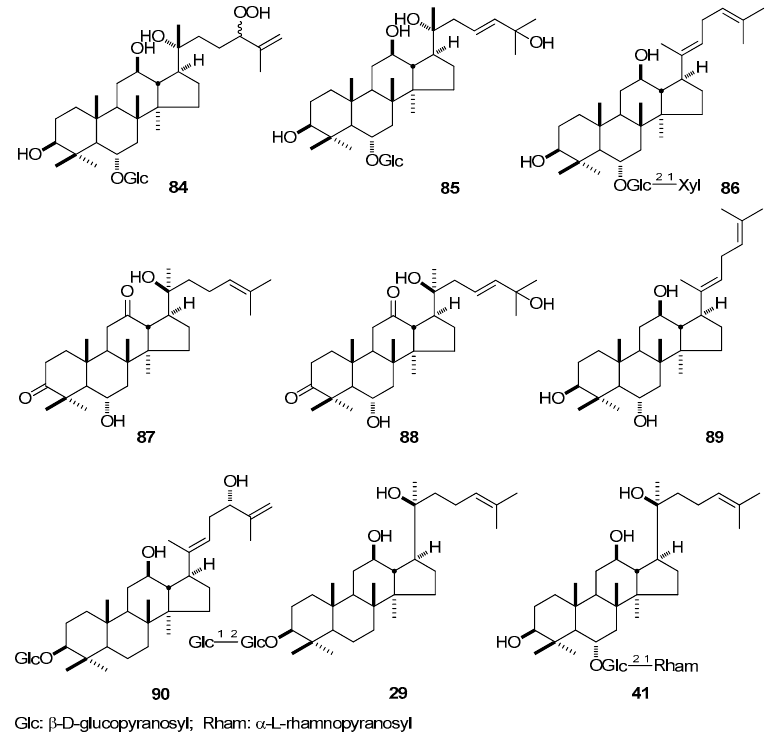
Figure 10. The structure of compounds 29 , 41 , 84 – 90.